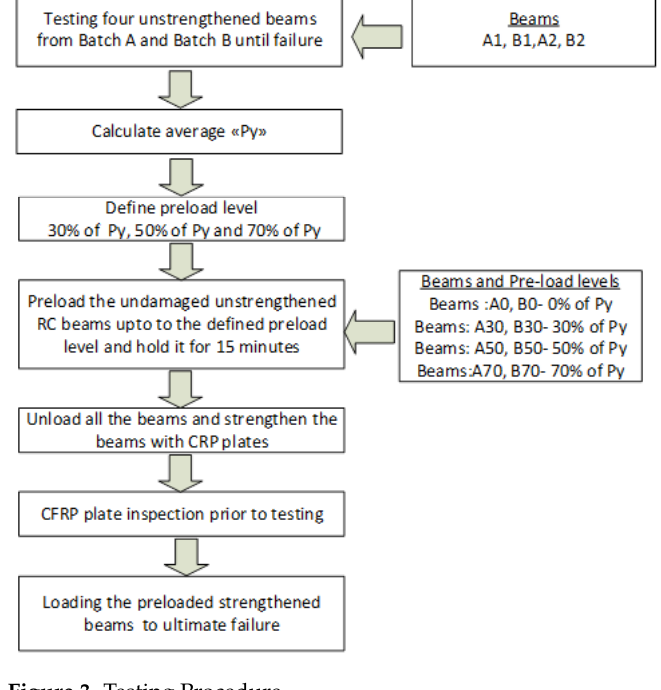
Figure 3. Testing Procedure.